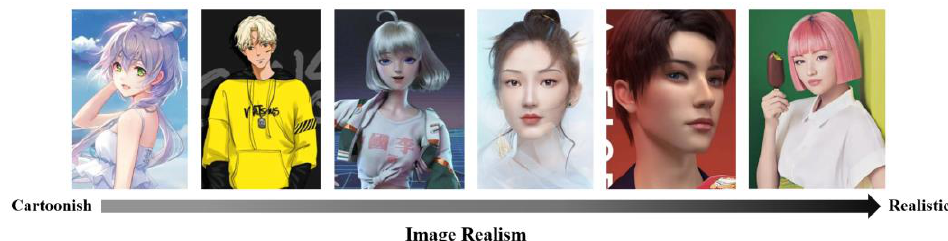
Figure 1. Example of digital endorsers’ image.